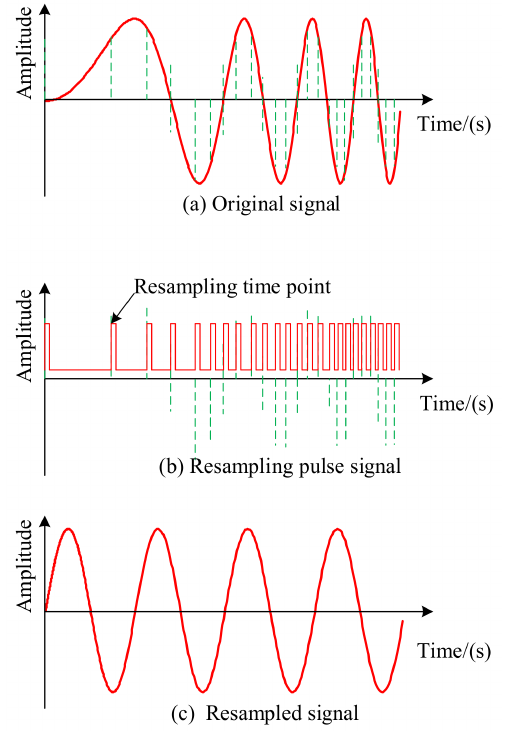
Figure 1. Schematic diagram of order